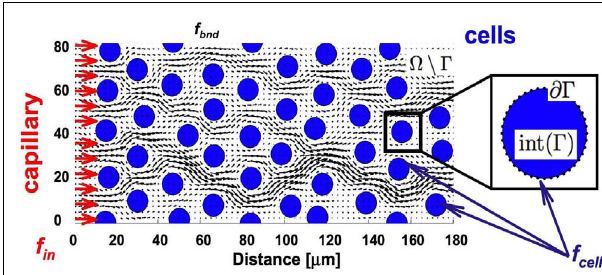
FIGURE 2 |Tissue scheme in the model . Schematic representation of the computational domain containing several tumor cells (blue circles) surrounded by the interstitial fluid (black arrows) that is supplied from the capillary located at the left border of the domain (red arrows). Adequate forces ( f in and f bnd ) are chosen to create the physiological fluid flow and to keep the boundaries of all tumor cells immobile ( f cell